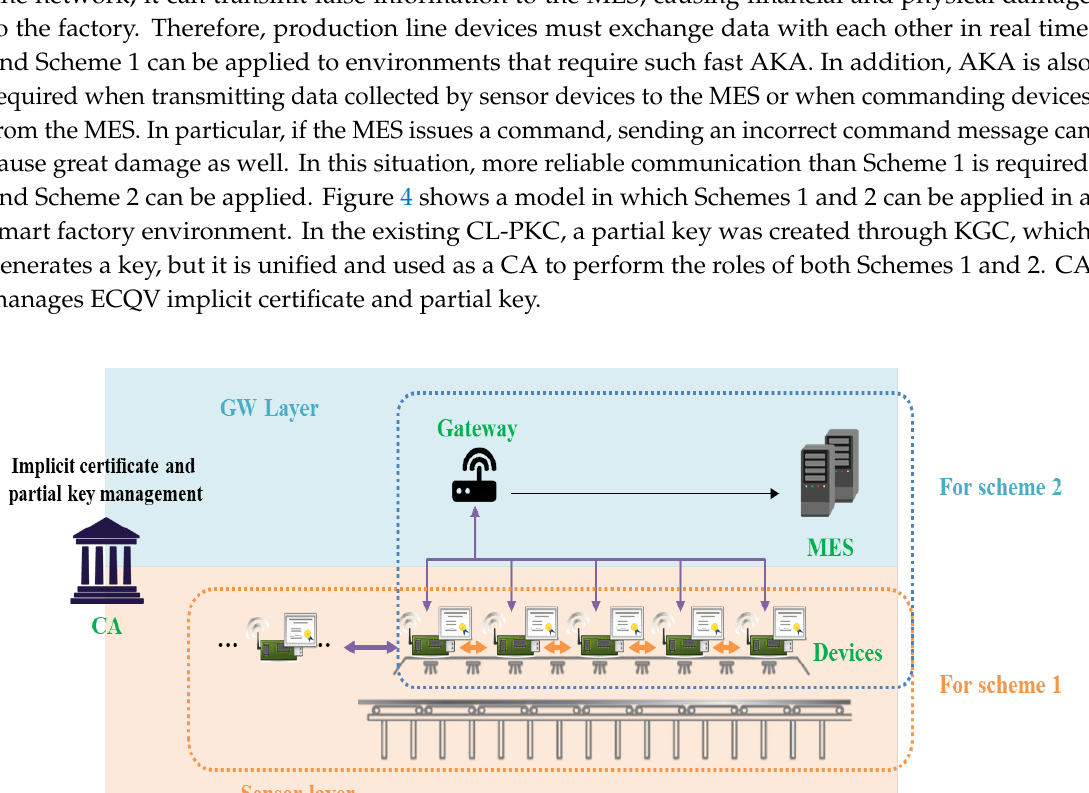
Figure 5. The scenario of Scheme 1. ECQV, elliptic curve Qu–Vanstone. 1.